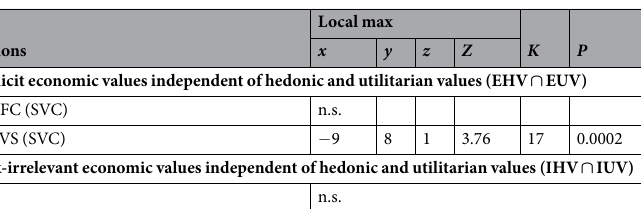
Table 1. Neural value-type common representations. Brain regions showing common value representations for hedonic and utilitarian goods at explicit (EHV ∩ EUV) and task-irrelevant (IHV ∩ IUV) value judgments.A conjunction analysis based on a conjunction null hypothesis. The uncorrected statistical threshold was p < 0.001, which was corrected to p < 0.05 using cluster size. Coordinates are reported in the stereotaxic space of the MNI. Abbreviations: vmPFC (ventromedial prefrontal cortex); VS (ventral striatum); SVC (small volume correction); EUV (explicit utilitarian values); IHV (task-irrelevant hedonic values); EHV (explicit hedonic values); IUV (task-irrelevant utilitarian values); n.s. (non-significant); MNI (Montreal Neurological